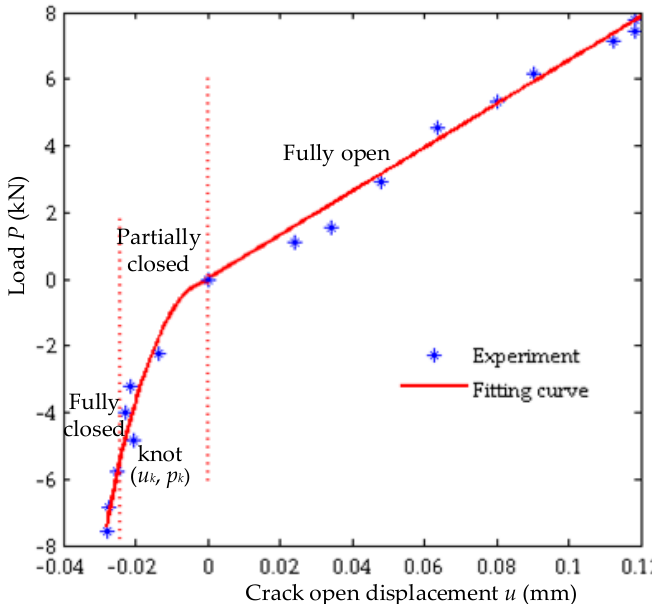
Figure 2. Load versus crack open displacement.